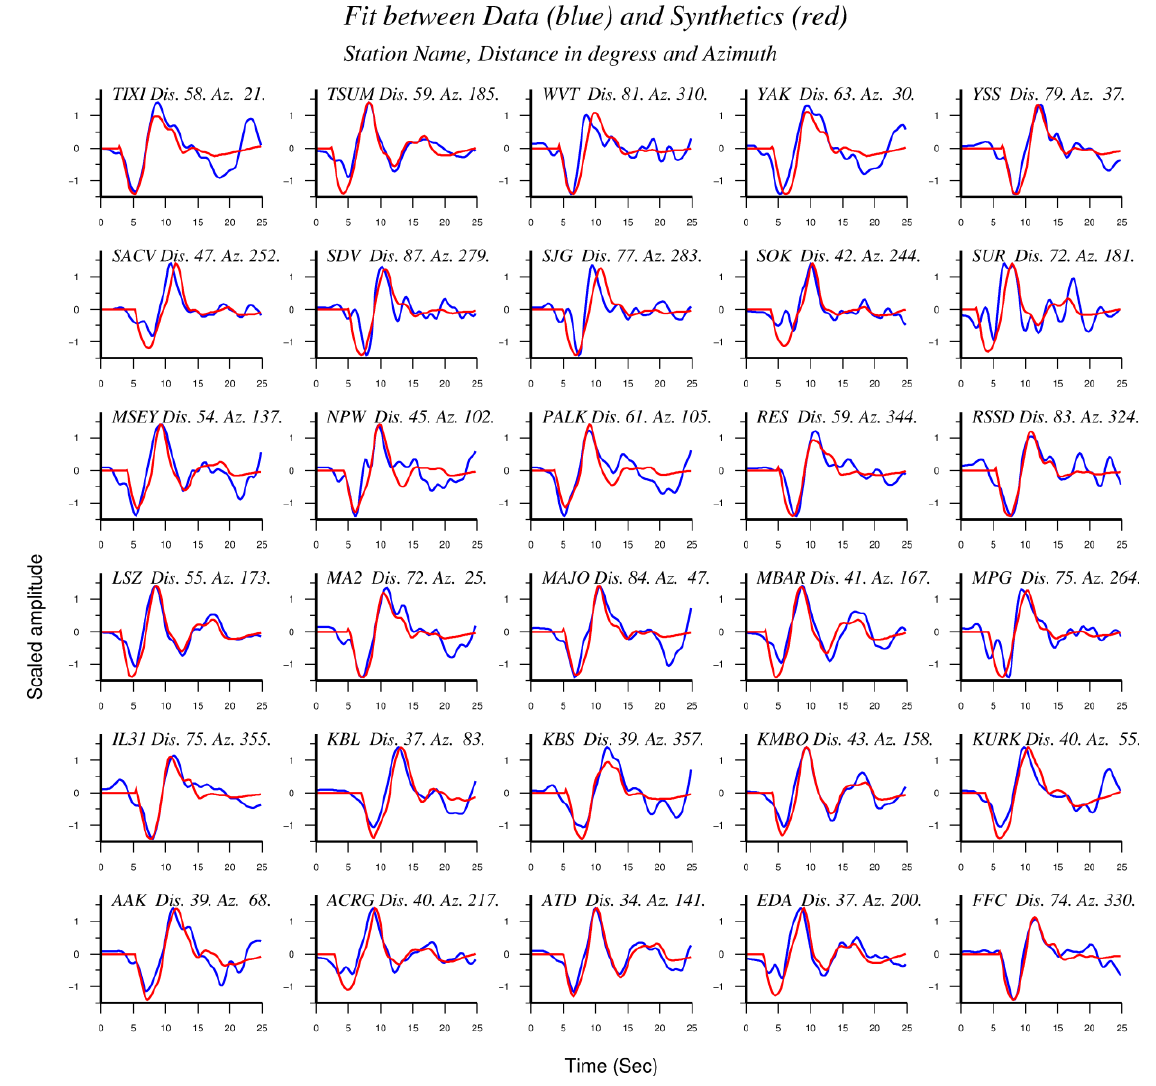
Figure 5. Scaled fit between real waveforms (blue lines) and synthetics (red lines) for the 30 stations; station name (e.g., TIXI), station epicentral distance in degrees (Dis.) and azimuth (Az.) are also shown.